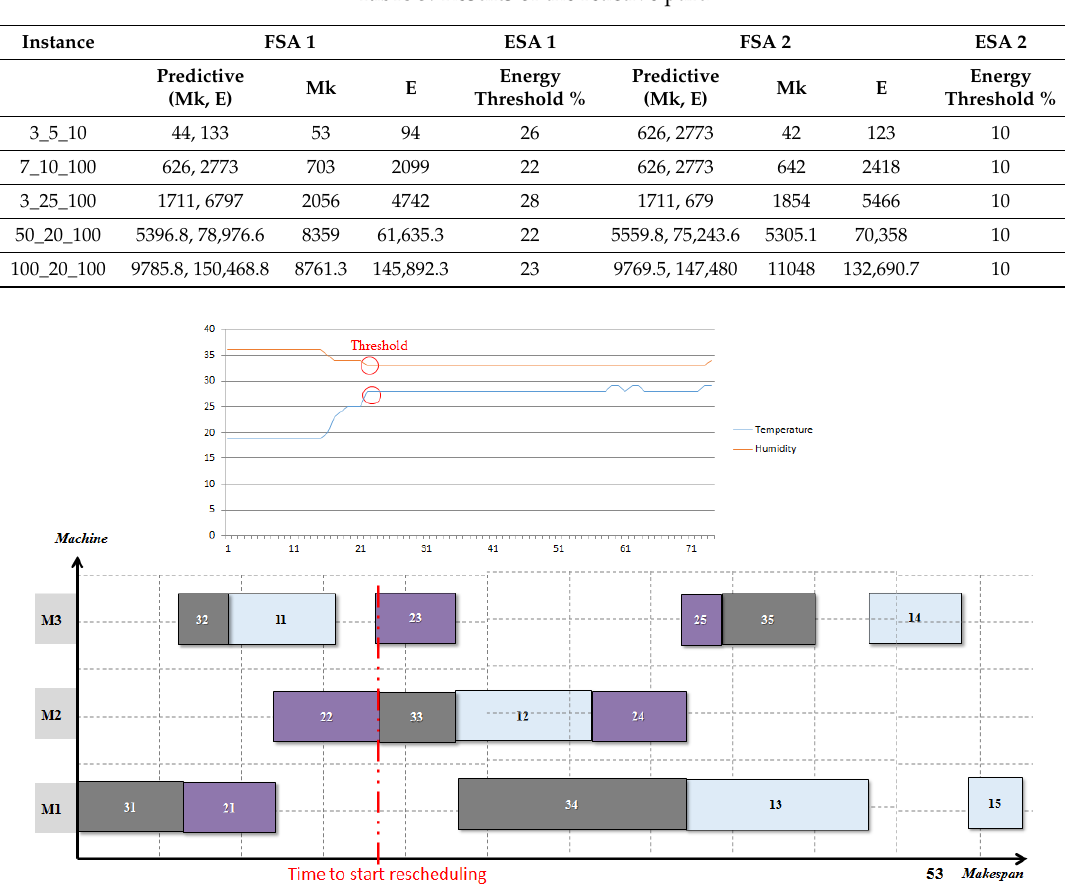
Figure 14. The reactive solution found by EasySched.